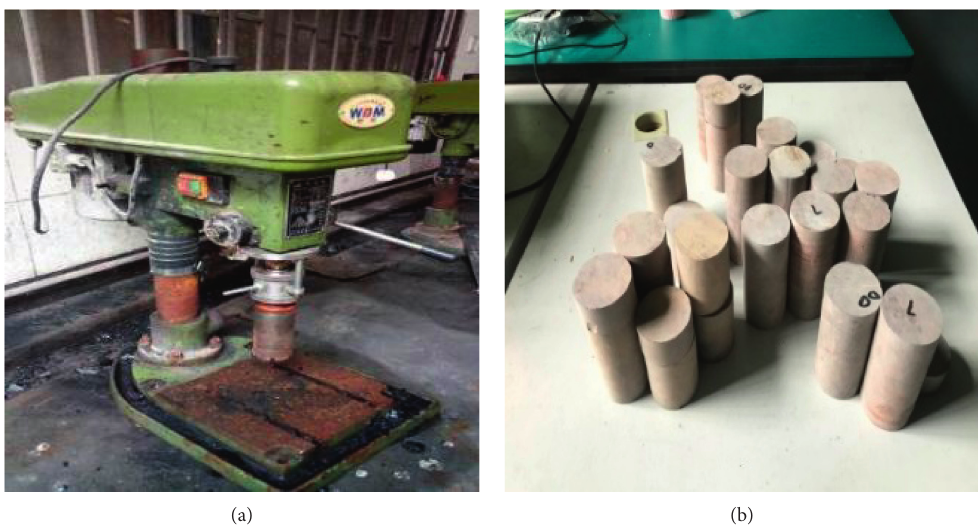
Figure 2: Mudstone specimen preparation. (a) Core-drilling machine. (b) Mudstone